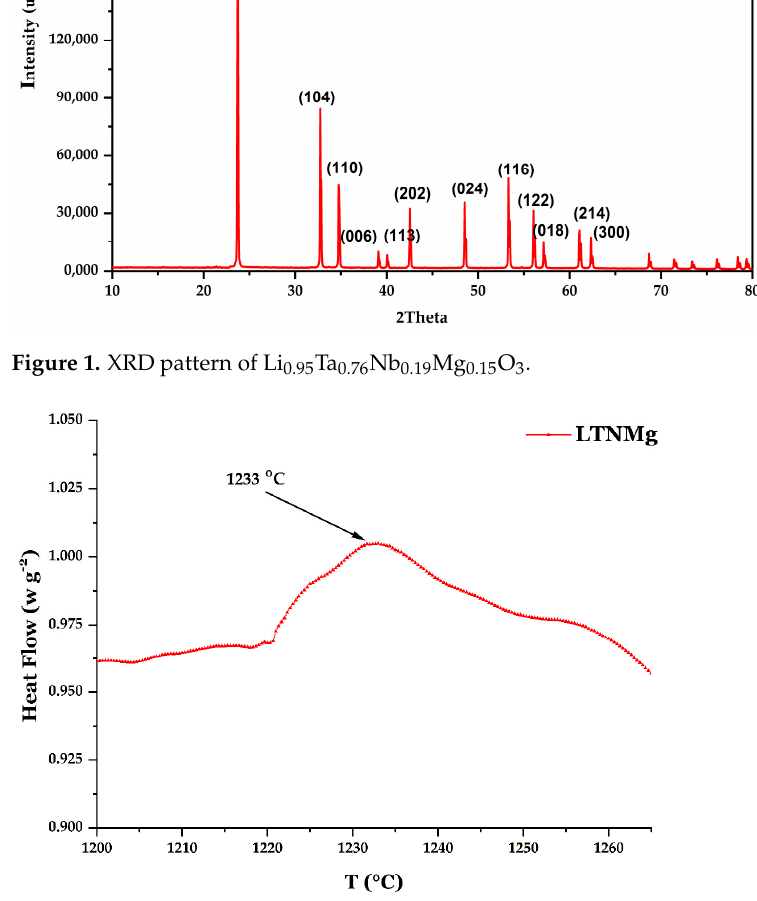
Figure 1. XRD pattern of Li 0.95 Ta 0.76 Nb 0.19 Mg 0.15 O 3.